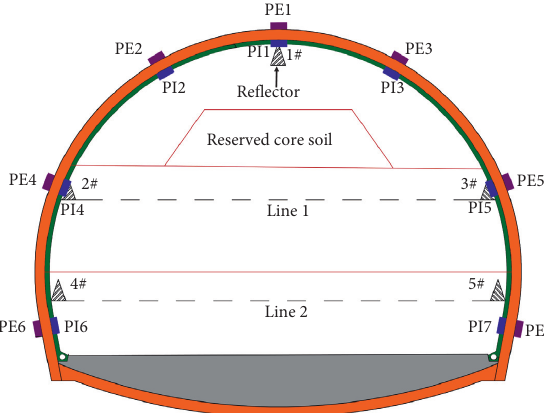
Figure 15: Layout of deformation measurement for stepped tunnel.